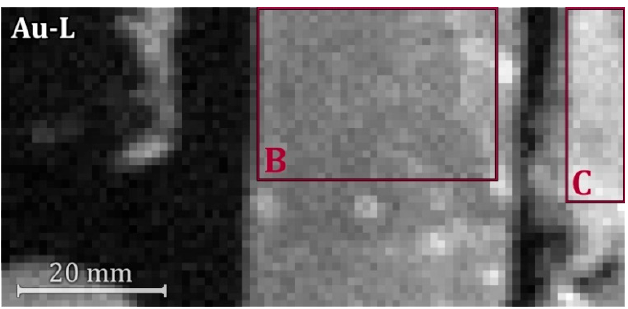
Figure 3. Elemental distribution map of Au-L series and areas of interest (AoIs) selected for calculating the gold leaf thickness. the gold leaf